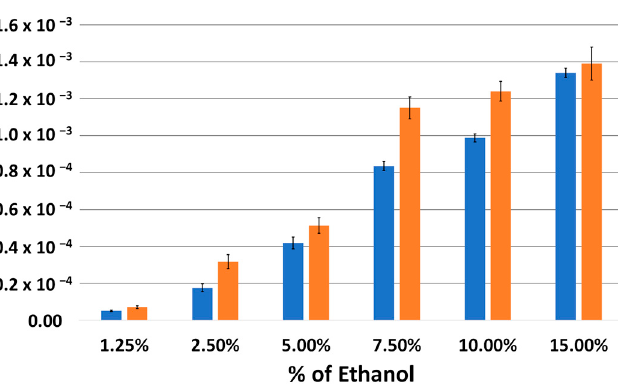
Figure 3. Comparison by bar chart diagram of the slope values of the tangent line at the point of maximum slope to the obtained curves, without (blue bars) and with (orange bars) LDHs (63 mg), at the different percentages of hydroalcoholic solution